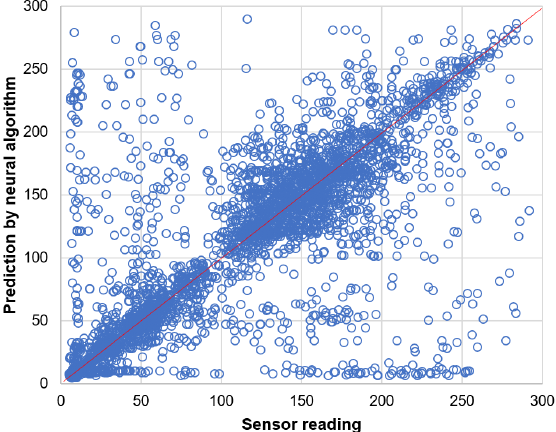
Figure 15. Prediction of light sensor readings by neural